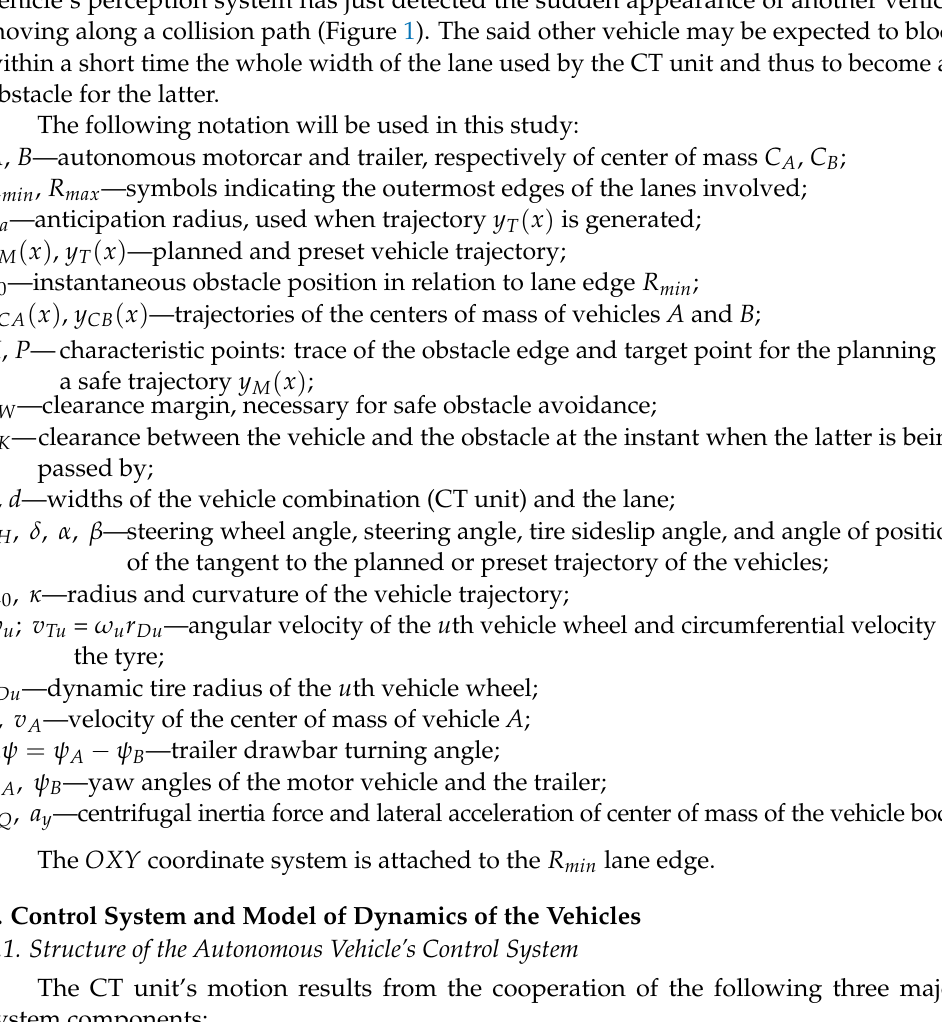
(2) Figure 3. Schematic diagram of the processing of trajectory 𝑦 (cid:3014) (𝑥) in order to determine the steering wheel angle 𝛿 (cid:3009) settings. In Equation (2), the properties of the anticipating model and the value of the antici- pation radius 𝐿 (cid:3028) are made use of. The determination of the anticipation radius value, to- gether with the method of planning the vehicle trajectory for the critical situation under analysis, has been presented in Section 6. Trajectory 𝑦 (cid:3021) (𝑥) and path 𝑦 (cid:3004)(cid:3002) (𝑥) of the center of mass of the motor vehicle make a basis for determining the ∆𝑦 and ∆𝛽 values. The ∆𝑦 and ∆𝛽 values describe the divergence between the trajectory planned and the actual vehicle path. They have been shown in Figure 4: Δ𝑦 = 𝑦 (cid:3021) (𝑥) − 𝑦 (cid:3004)(cid:3002) (𝑥) Δ𝛽 = 𝛽 (cid:3021) (𝑥) − 𝛽 (cid:3004)(cid:3002) (𝑥)